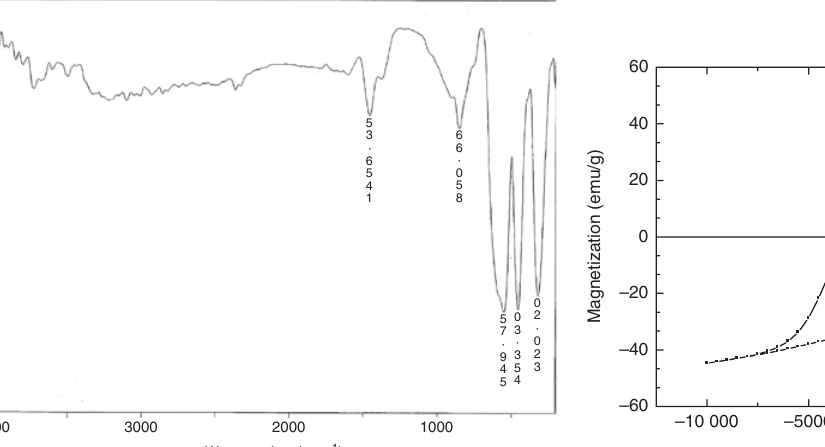
Figure 9: FT-IR spectrum of nanoparticles obtained at 500 ° C.